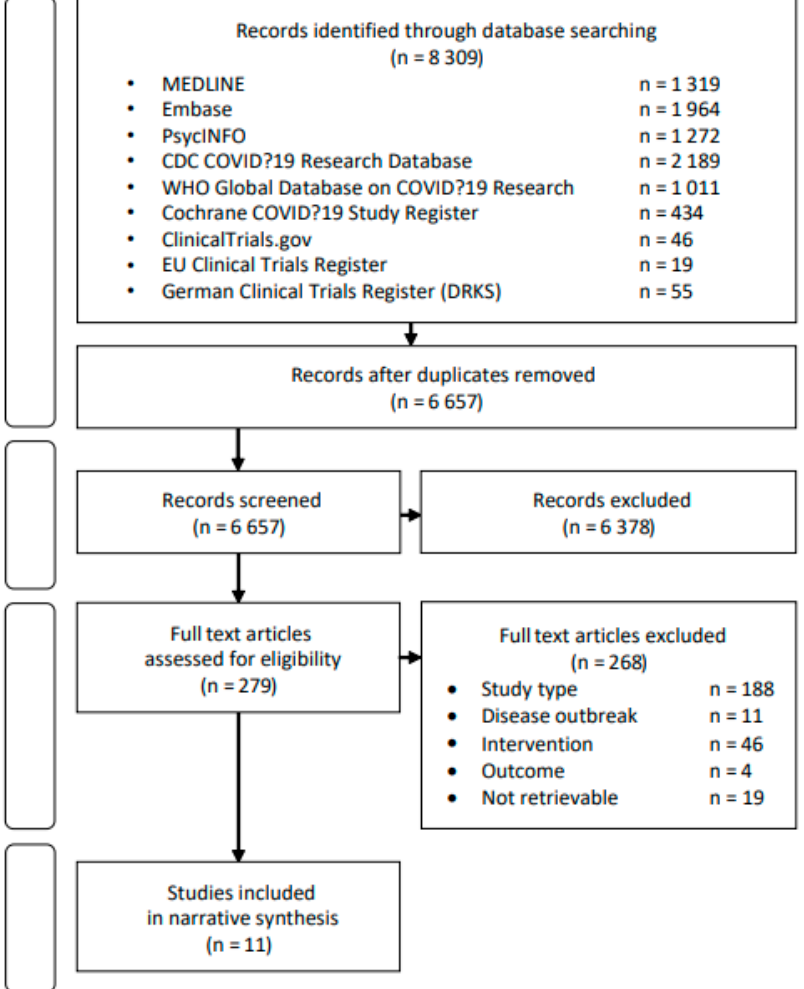
Figure 1. Preferred Reporting Items for Systematic Reviews and Meta-Analyses (PRISMA) flow chart.